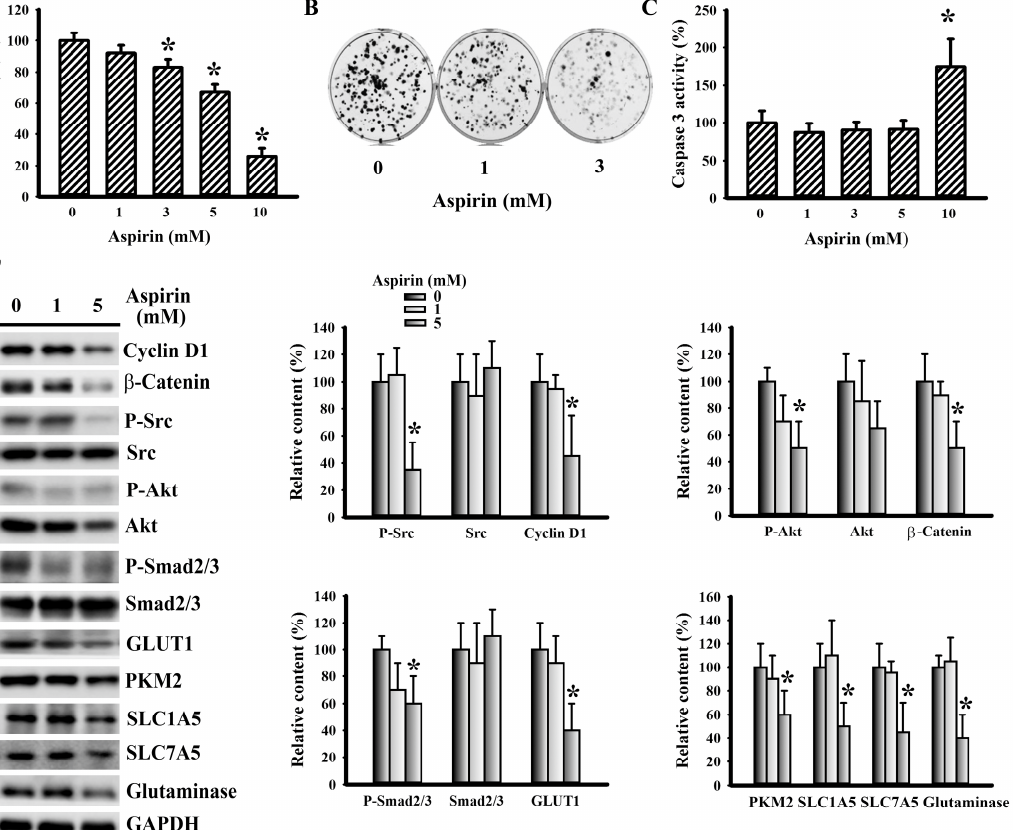
Figure 6. Aspirin mitigated LLC cell proliferation. ( A ) LLC cells were treated with various concentrations of aspirin for 24 h. Cell viability was evaluated by MTS reduction assay. ( B ) LLC cells were treated with various concentrations of aspirin for 6 days. Cell colonies were fixed and stained with crystal violet. ( C ) LLC cells were treated with various concentrations of aspirin for 16 h. Proteins were extracted and subjected to enzymatic assay of caspase 3 activity. ( D ) LLC cells were treated with various concentrations of aspirin for 16 h. Proteins were extracted and subjected to Western blot with indicated antibodies. Representative blot is shown. Quantitative data are depicted and the content in untreated control was defined as 100%. * p < 0.05 vs. untreated control (n = 3).